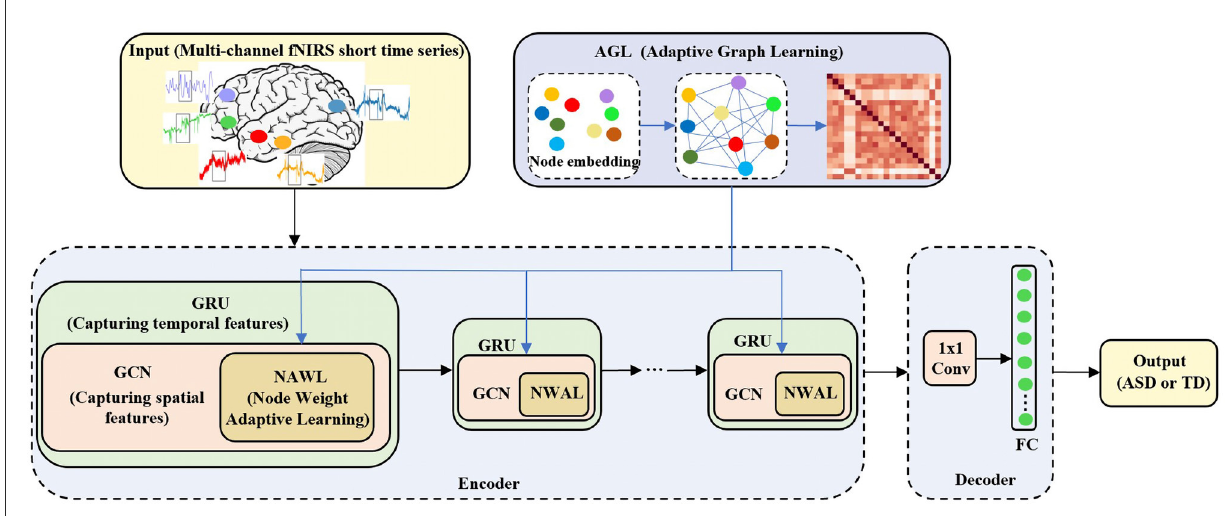
FIGURE3 The specific structure of the ASGCN model. ASGCN model consists of an encoder and a decoder. The encoder part stacks multi-layer ASGCN modules, and each ASGCN module combines an improved GCN module (including adaptive graph learning (AGL) module and node weight adaptive learning (NWAL) module) and a GRU module. The decoder part consists of a 1 × 1 convolutional module and a fully connected